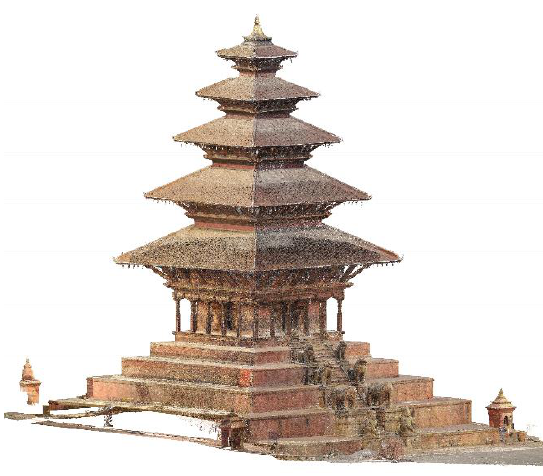
Figure 5. Combined 3D point cloud from laser scanner and aerial photogrammetry